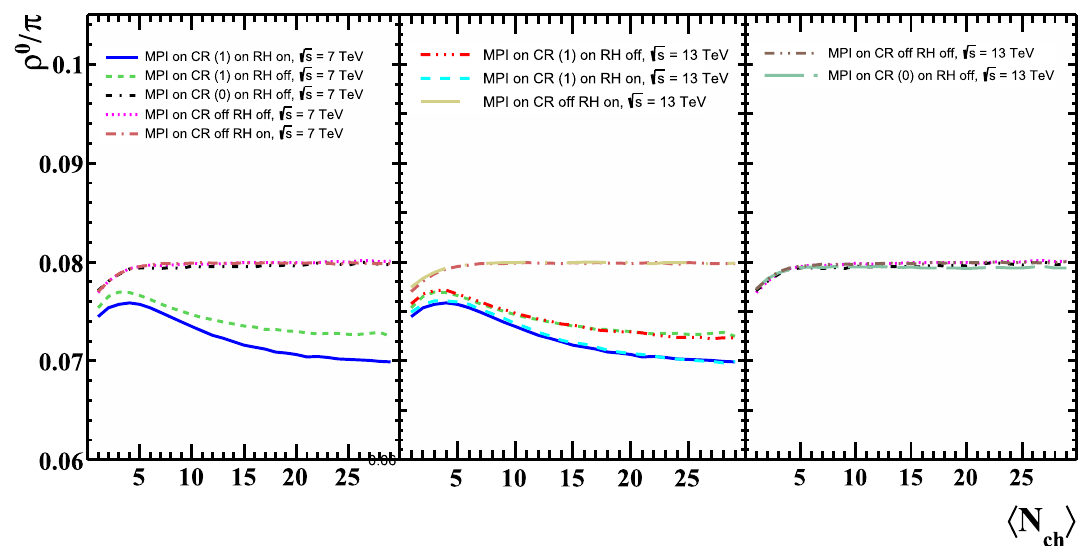
√ s = 7 TeVand13 TeVfor CR-off, CR(0)andCR(1)with collisionsat RH. (Right panel) Comparison of ratios for p–p collisions at TeVand13TeVfortwoothermodes,namelyCR-offandCR(0)without